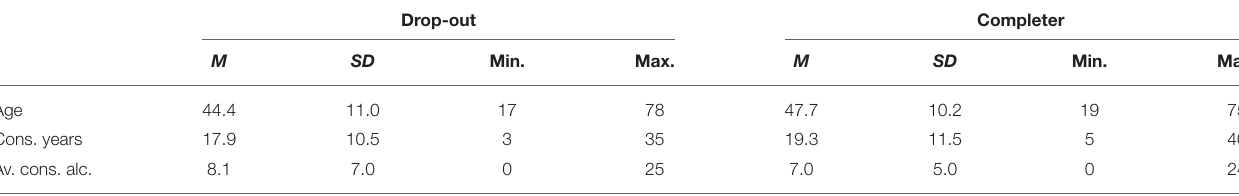
TABLE 1 | Overview of the client’s age, years of problematic alcohol consumption, and the average units of consumed alcohol. Drop-out Completer SD Min.